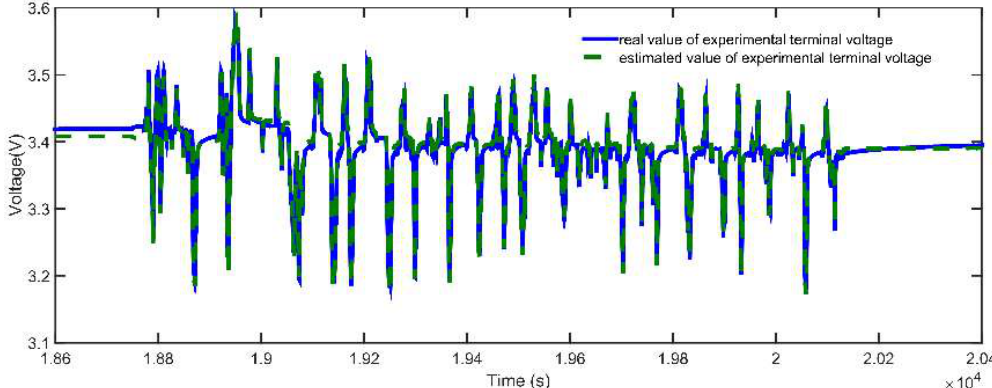
Figure 8. Comparison of real and estimated voltage of test 1 under dynamic condition.